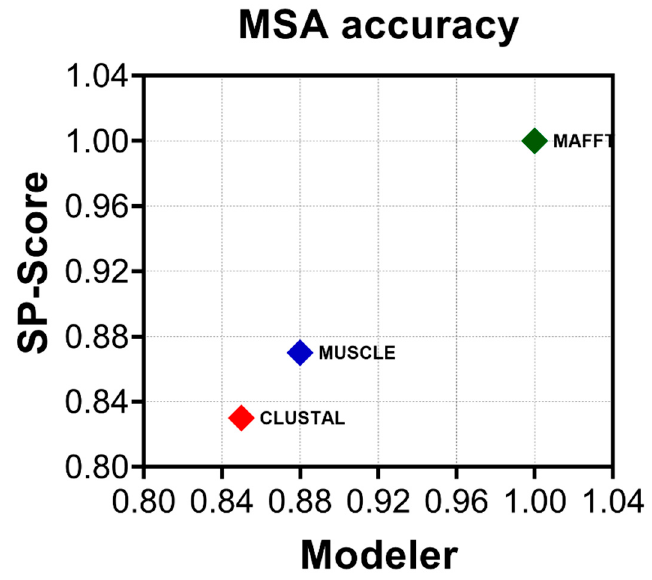
Figure 2. MAFFT provides the most accurate alignment. The average modeler score (precision) versus sum of pairs score (SP-score) (recall) for all three methods used to align the dataset: CLUSTALW (red), MUSCLE (blue), and MAFFT E-INS-i (green). Estimations were performed using a linear time calculation of alignment accuracy (FASTSP) [24]. Table 1. Topology comparison for different alignment methods for the RdRp gene of PBVs using all 403 complete gene sequences available at the GenBank database. (Best topology detected is highlighted in bold).